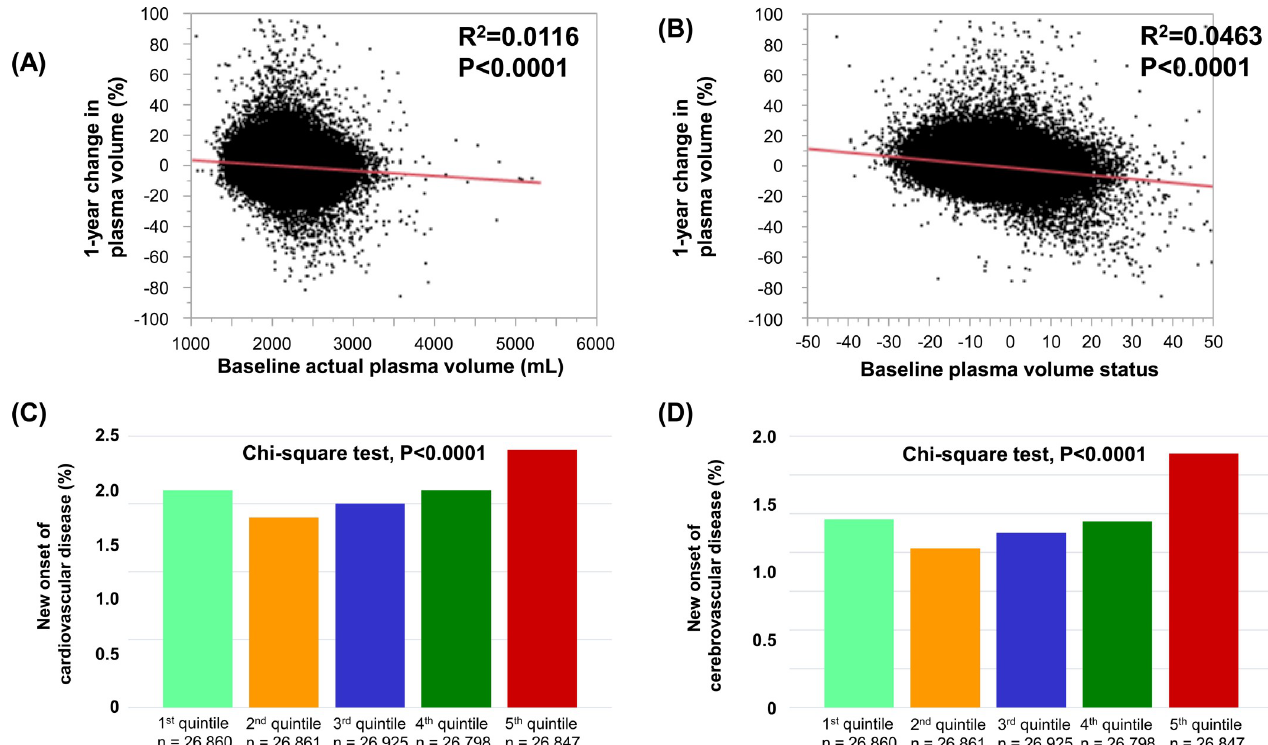
Fig 3. Association of 1-year change in plasma volume with baseline actual plasma volume (A) and plasma volume status (B). Comparisons of the rates of new onset cardiovascular disease (C) and cerebrovascular disease (D) among quintiles based on the 1-year change in plasma volume.